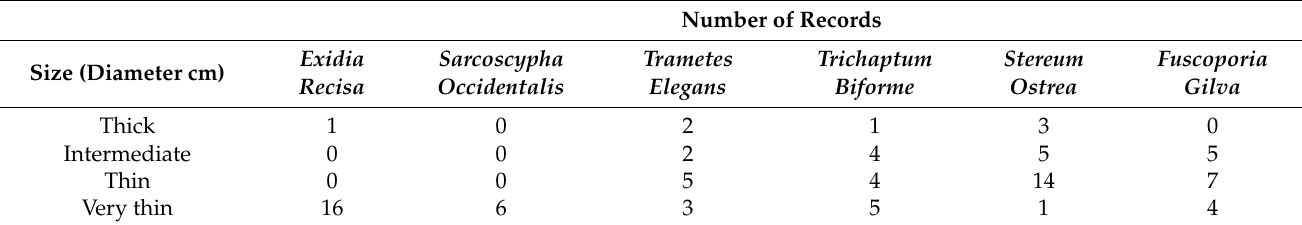
Table 2. Distribution of fungi in relation to the diameter of the woody substrate. Number of Records